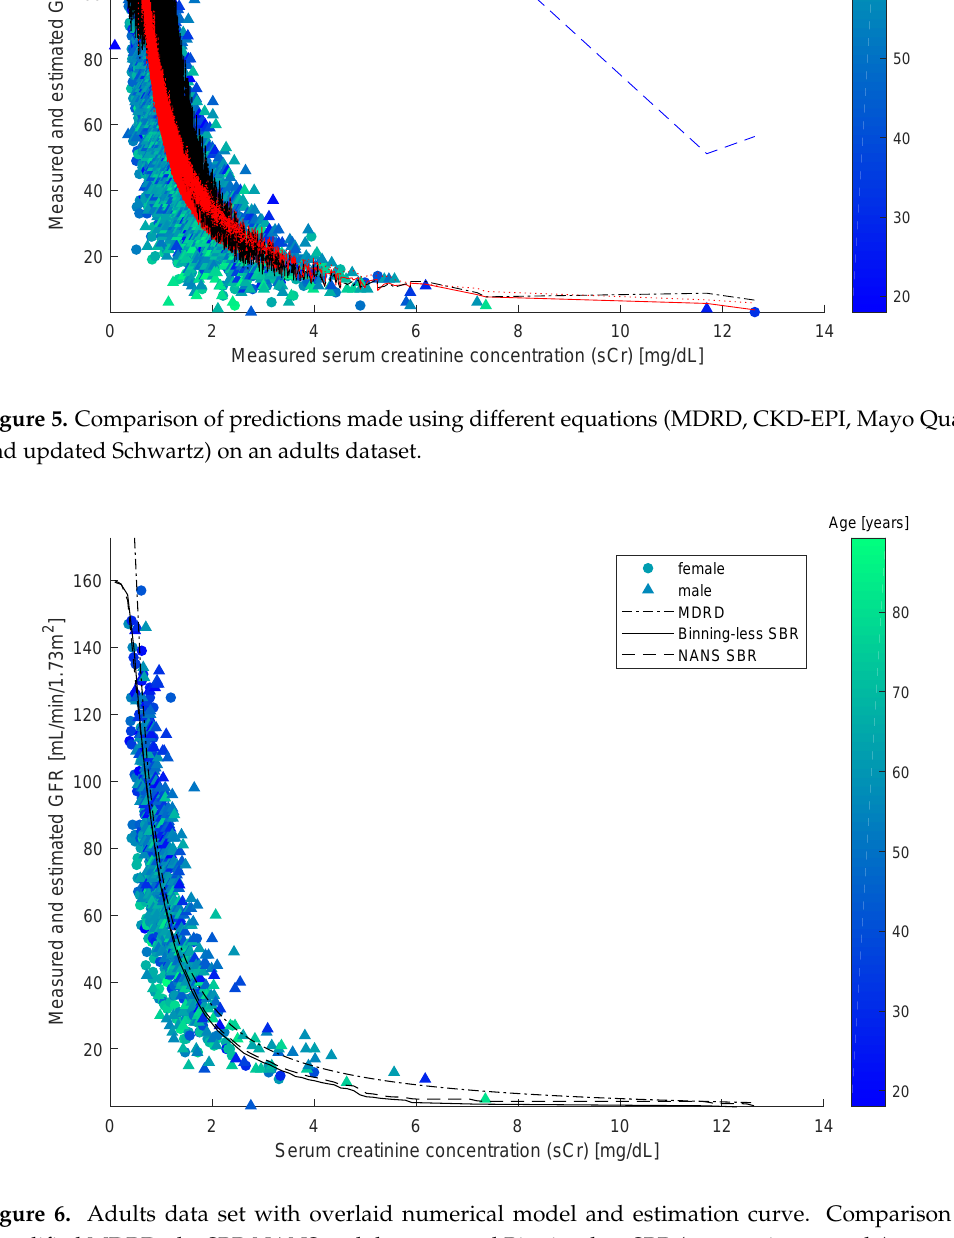
Figure 6. Adults data set with overlaid numerical model and estimation curve. Comparison of the Simplified MDRD, the SBR NANS and the proposed Binning-less SBR (on a testing set